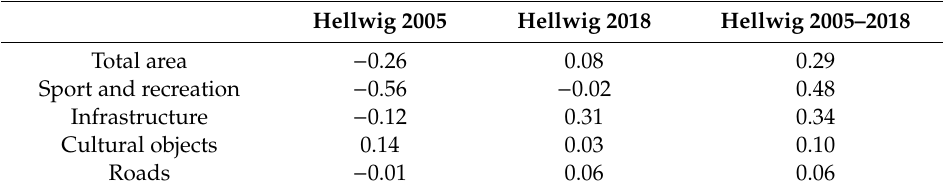
Table 4. Pearson correlation coefficient values for all analysis variants/districts.